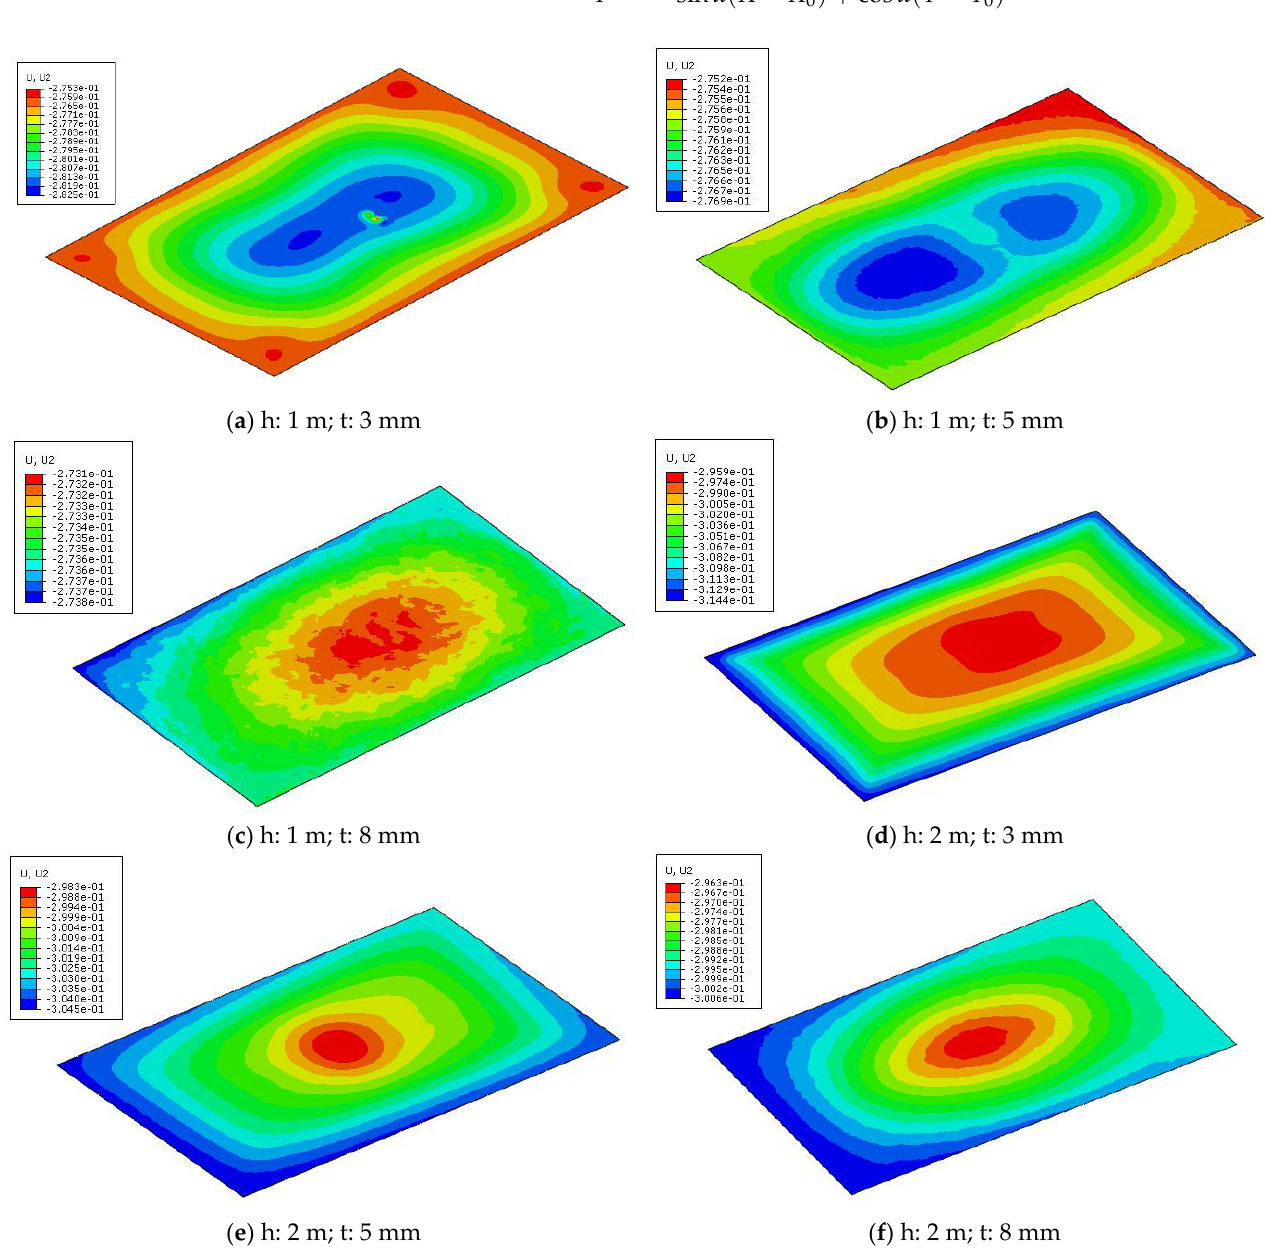
Figure 10. Plastic deformation contour in vertical direction.